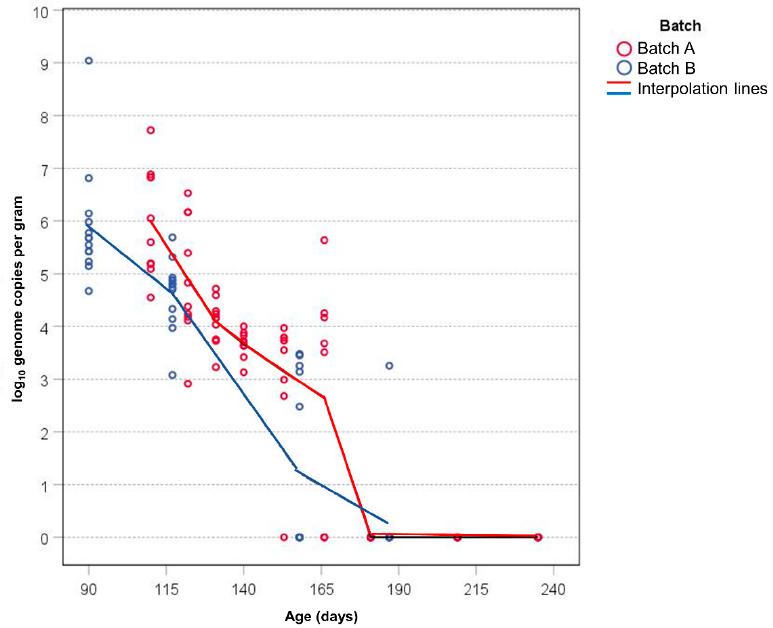
10 of the GC/g obtained.